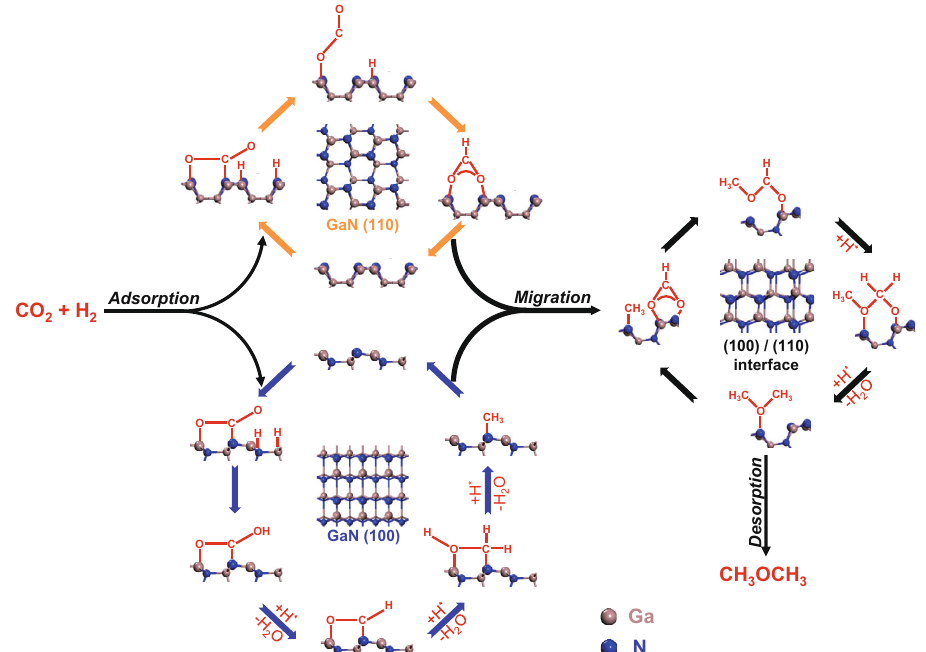
Fig. 8 The mechanism for CO 2 to DME catalyzed by GaN. The route with orange arrows: elementary steps for the formation of HCOO* over the (110) plane. The route with blue arrows: elementary steps for the formation of CH 3 * over the (100) plane. The route with black arrows: elementary steps for the formation of DME over the (100)/(110)